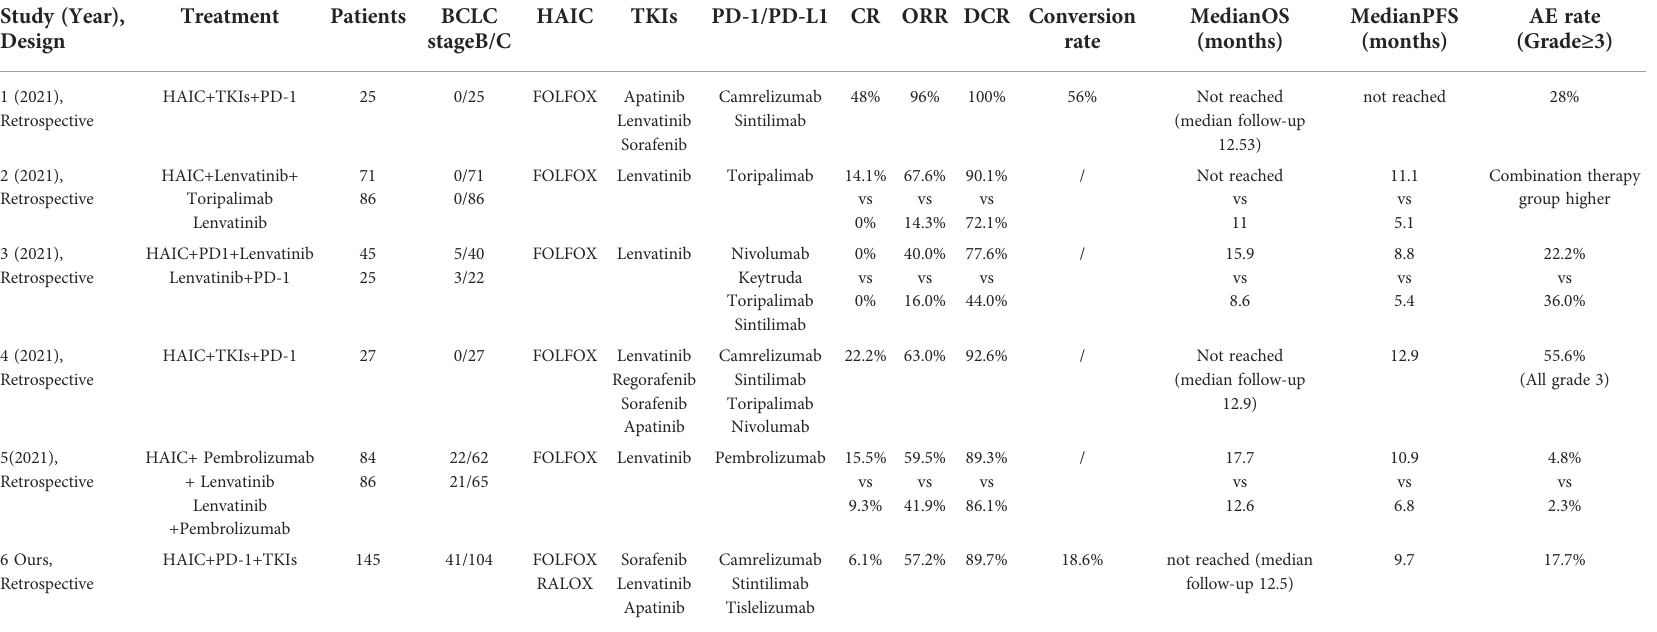
TABLE 5 Published literature for HCC patients received HAIC+TKIs+PD-1